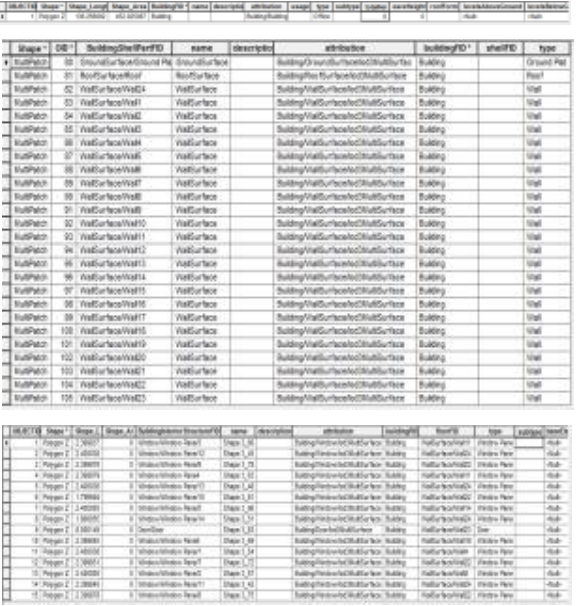
Figure 16: The index of the Building, the BuildindShellPart and the BuildingInteriorStructure